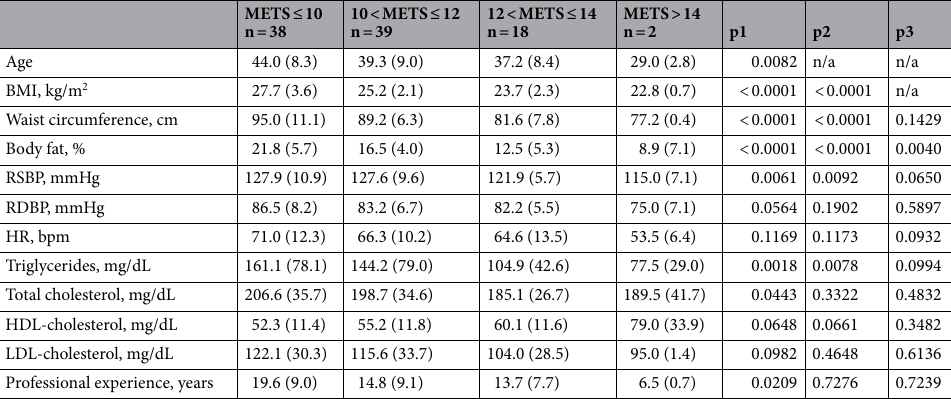
Table 2. Cardiovascular risk factors of each METS category. p1: unadjusted; p2: adjusted for age; p3: adjusted for age and BMI. BMI body mass index, HR heart rate, RDBP diastolic resting blood pressure, RSBP systolic resting blood